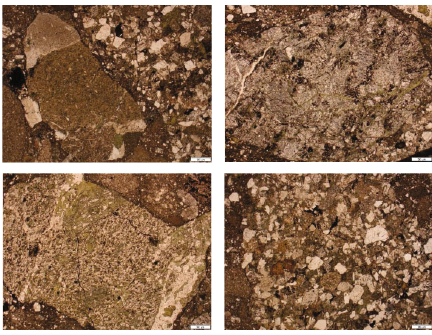
Figure 8: Some images of rock thin